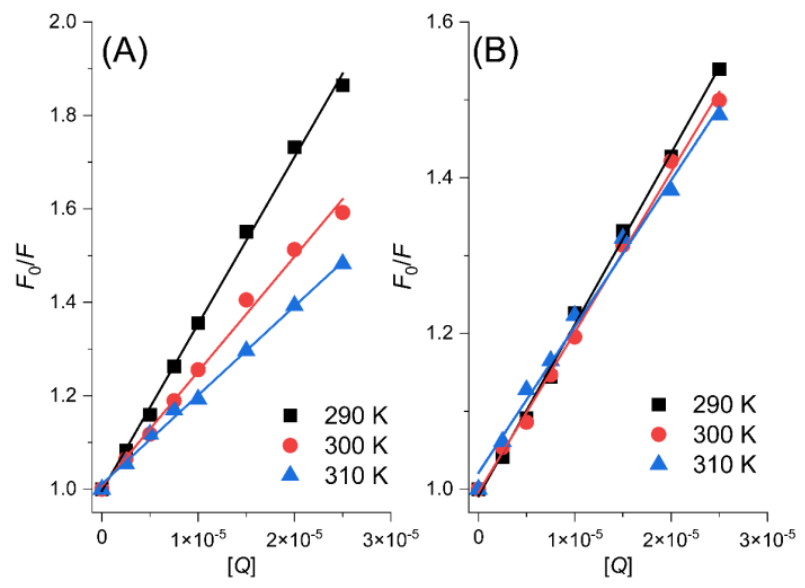
Figure 3. Stern-Volmer plots for PK-MYR ( A ) and PK-MYT ( B ). Normally, the maximum collisional quenching constant K q is about 2 × 10 10 L · mol − 1 · s − 1 for small molecule quenchers and biomolecules [19]. If a measured K q is much larger than 2 × 10 10 L · mol − 1 · s − 1 , it indicates that the quenching induced by the quencher is static quenching. Table 1 gives the K q values for MYR and MYT at different temperatures, indicating that the quenching processes are both static. Meanwhile, the static quenching constants of PK-MYR exhibit a more remarkable change with increasing temperature, suggesting that the PK-MYR complex is less stable and more sensitive to higher temperature compared to the PK-MYT complex. Table 1. Calculated Stern–Volmer constant ( K sv ), fluorescence quenching rate constant ( K q ), binding constant ( K A ), and number of binding sites ( n A ) for the interactions of PK with MYR and MYT at different temperatures (T).